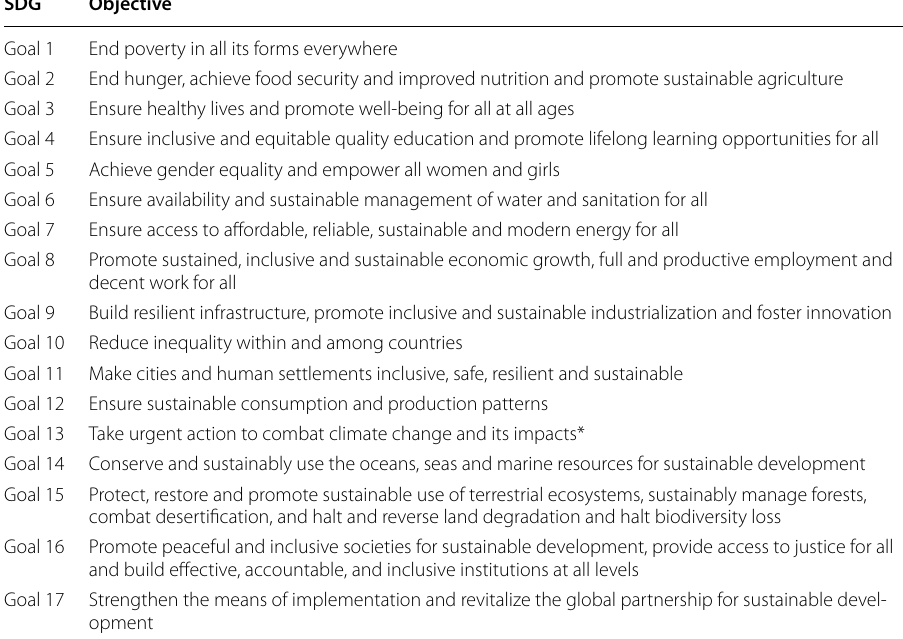
Table 1 United Nations Sustainable Development Goals (UN SDGs) of the 2030 agenda. Source : United Nations (2015) SDG Objective Goal 1 End poverty in all its forms everywhere Goal